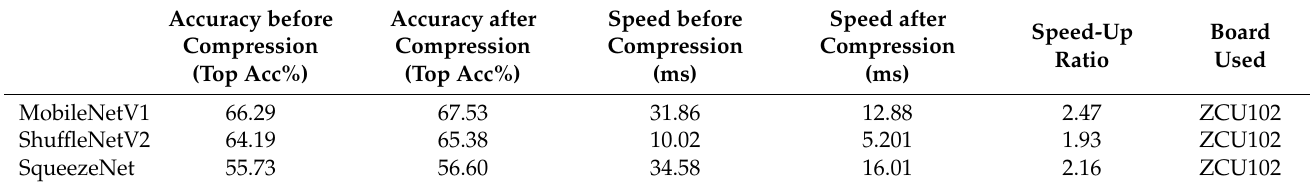
Table 1. Evaluation of FPGA.